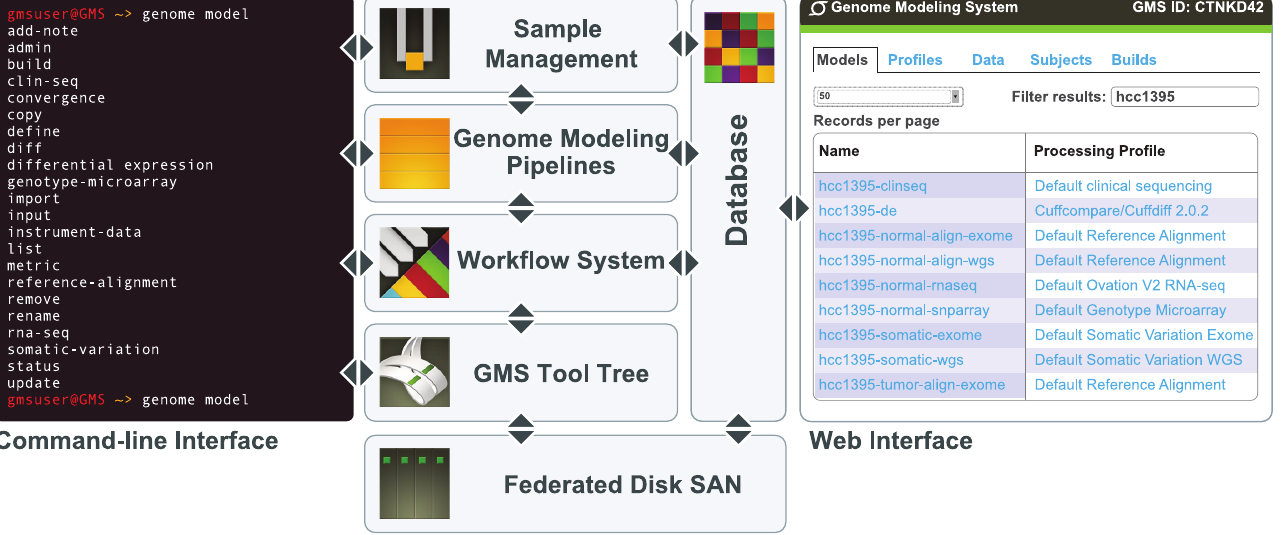
Fig 1. Overview of the GMS. The genome modeling system (GMS) is implemented to use a federated disk SAN, with meta-data stored in a PostgreSQL relational database. Sample management tools allow the import of new samples and instrument data. Data are then processed through various analysis pipelines (e.g., reference alignment, somatic variation detection, etc.) that in turn are managed and monitored by a workflow system (Box 1). Stand-alone GMS tools, not part of automated pipelines, are available through a common tool tree. Most components of the system can be accessed through an Ubuntu Linux command-line interface or Ruby-on-Rails web